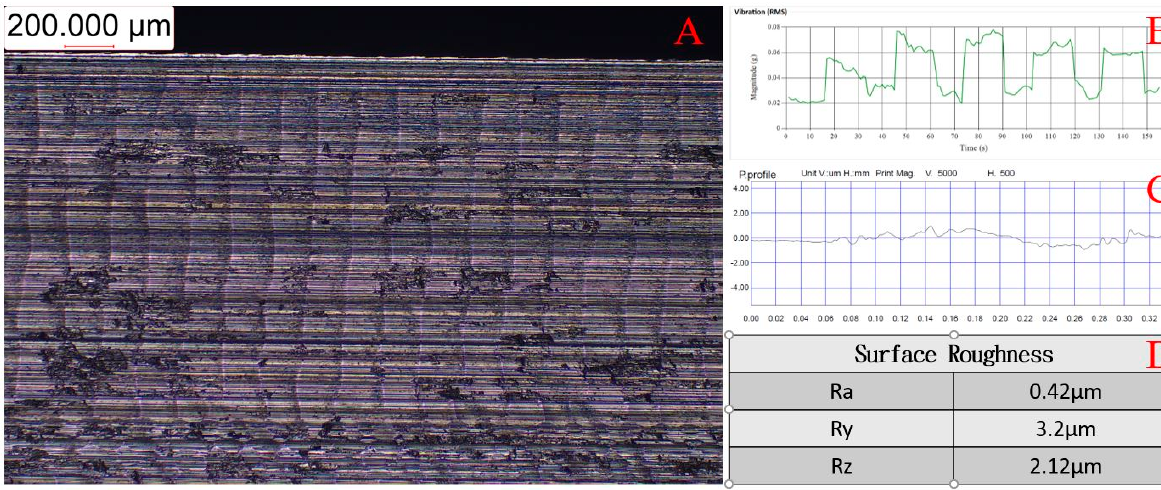
Figure 22. D8 measurement result of Parameter 1.